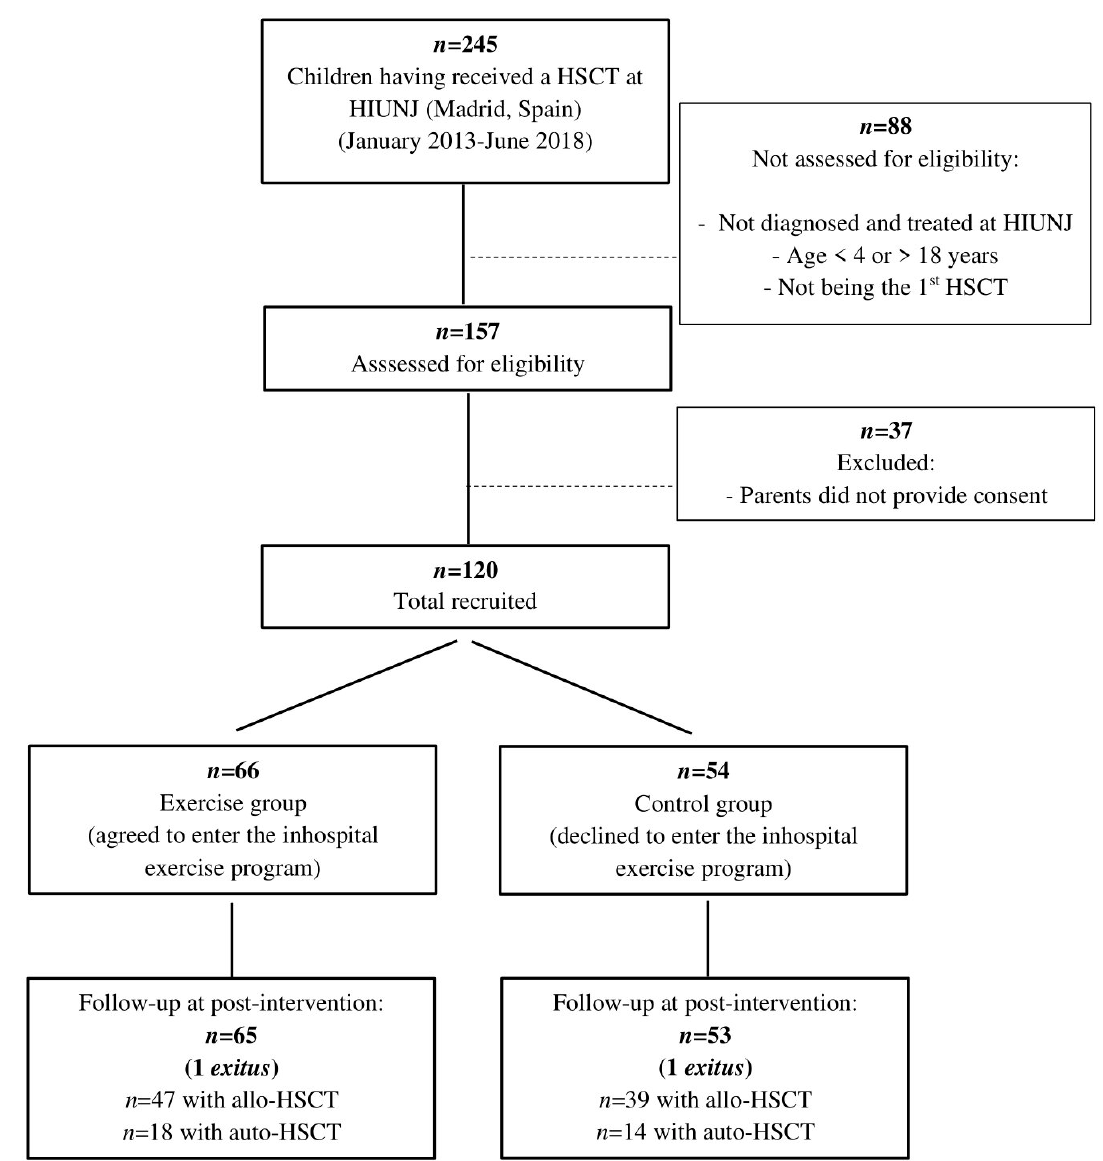
Figure 1. Flow diagram according to strengthening the reporting of observational studies in epidemiology statement. Abbreviations: allo-HSCT, allogeneic hematopoietic stem-cell transplantation; auto-HSCT, autologous hematopoietic stem-cell transplantation; HIUNJ, Hospital Infantil Universitario Niño Jes ú s; HSCT, hematopoietic stem cell Table 1. Main demographic and clinical characteristics by group.